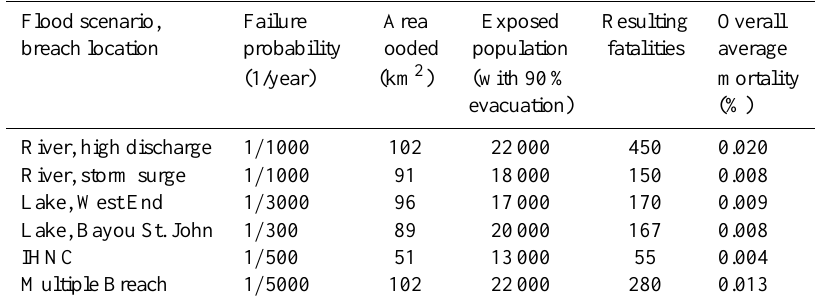
Table 1. Results: loss of life estimates and assumed failure probabilities for each scenario. For locations of the breaches, reference is made to Fig.